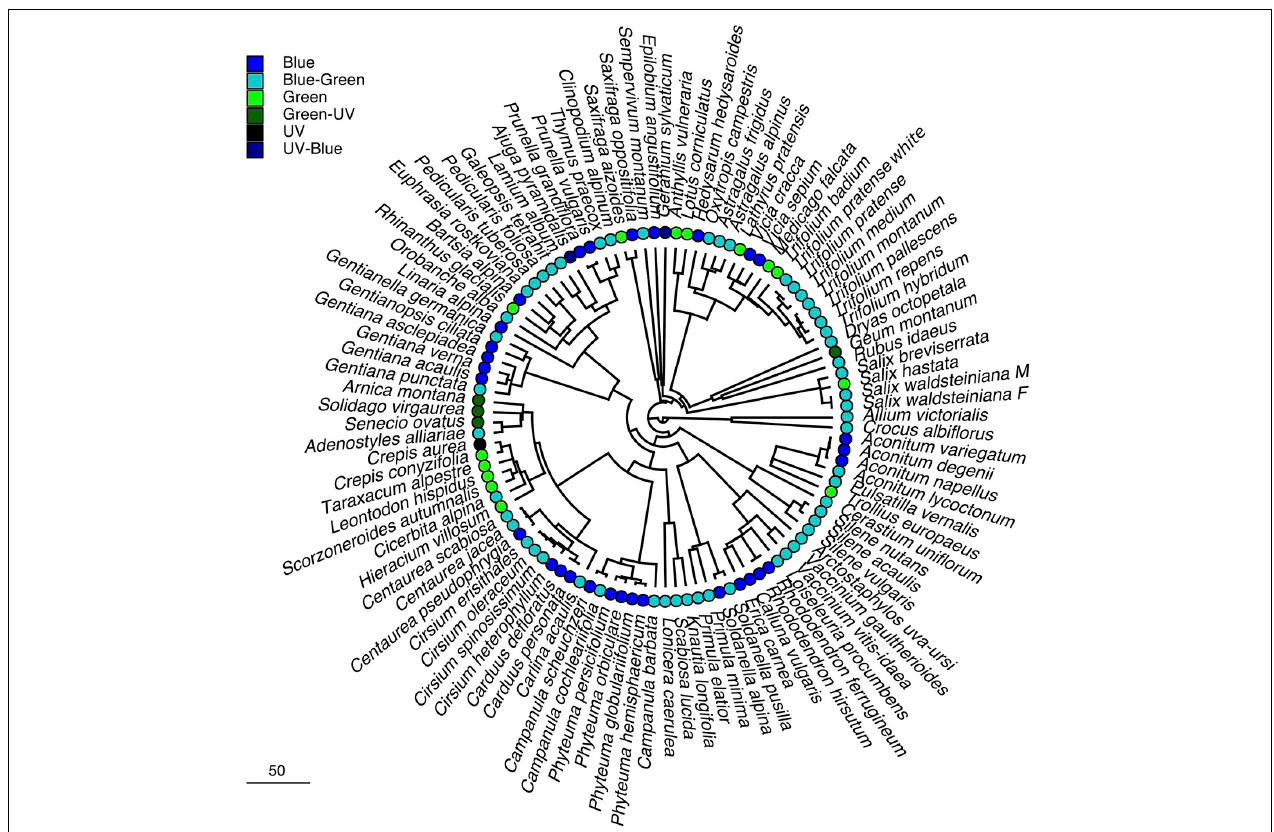
FIGURE 2 | Phylogenetic reconstruction of the studied plant species. Phylogenetic tree of the study species, based on the phylogenetic “ALLOTB” tree by Smith and Brown (2018). Colored circles refer to hexagon color category. Scale bar for branch length indicates divergence time in million years.